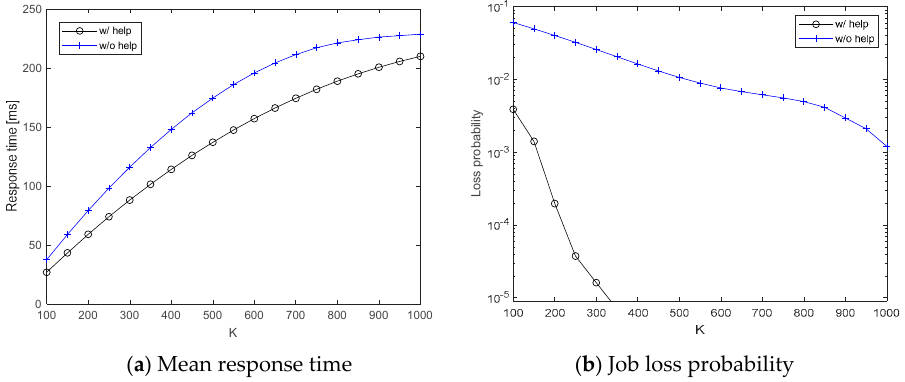
Figure 5. Application-level Quality of Service (QoS) parameters.